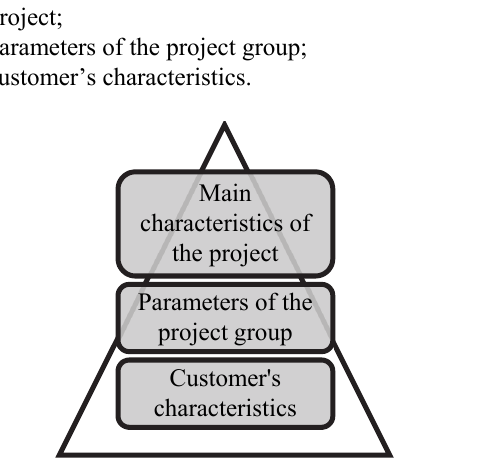
Fig. 2. Classification of selection criteria for software development